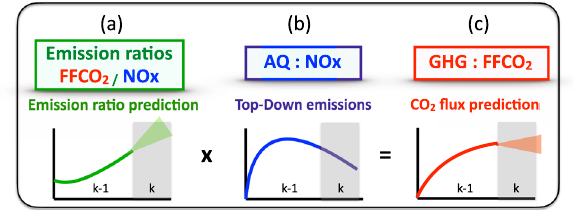
Fig.2|TheschematicdiagramoftheKalman fi lter(KF)prediction.a Changesin CO 2 /NO x emissionratiofortheprevioustimeperiods( t = k − 1)arediagnosedusing top-downNO x emissionsandbottom-upfossilfuelCO 2 (FFCO 2 )inventories. b CO 2 / NO x emission ratio for more recent time periods ( t = k ) is predicted using a KF optimal estimation approach based on information obtained from the previous time period ( t = k − 1). c A prediction of FFCO 2 for t = k is obtained from the pre- dicted emission ratio from b and the top-down NO x